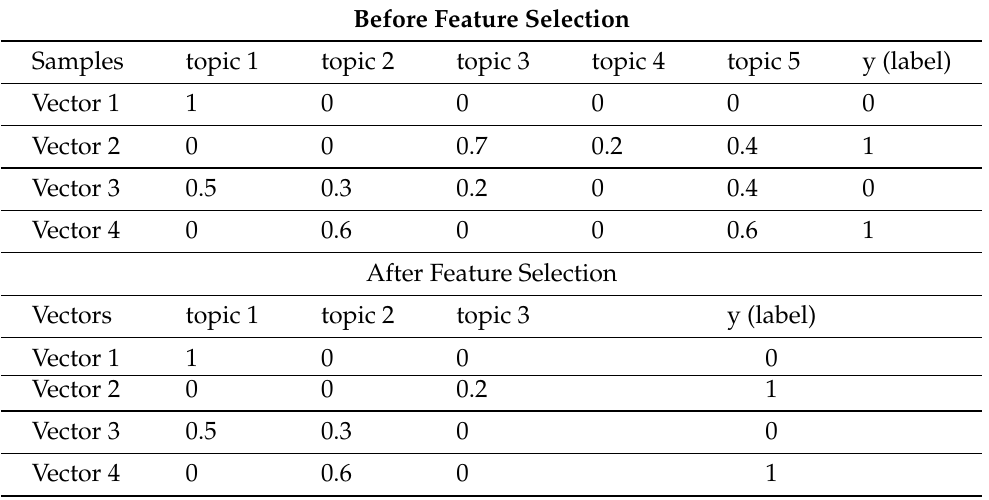
Table 2. Vertices before and after feature selection.